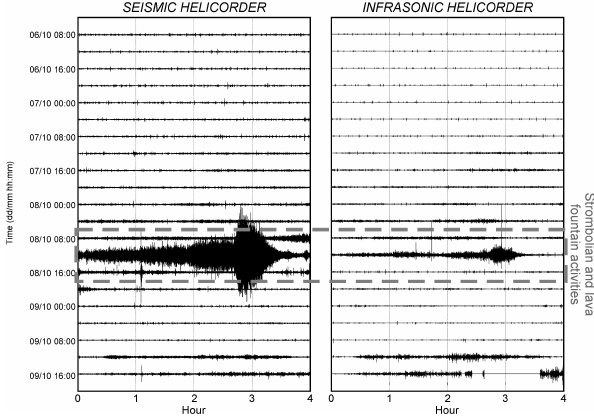
Fig. 5. Helicorder plots of seismic and infrasonic signals recorded from 6 to 9 October 2011 at EBEL station. The grey dashed rectan- gle indicates the time interval characterised by strombolian and lava fountain activities.